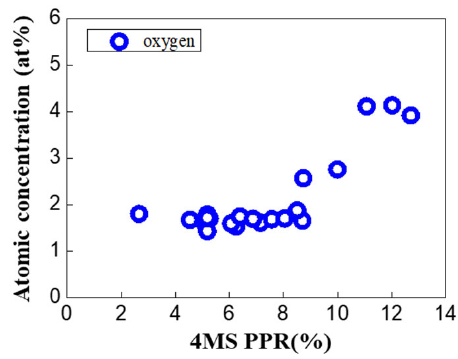
Figure 4. Oxygen concentration according to the 4MS PPR. In this experiment, the 4MS PPR in ‐ creased to over 8%.